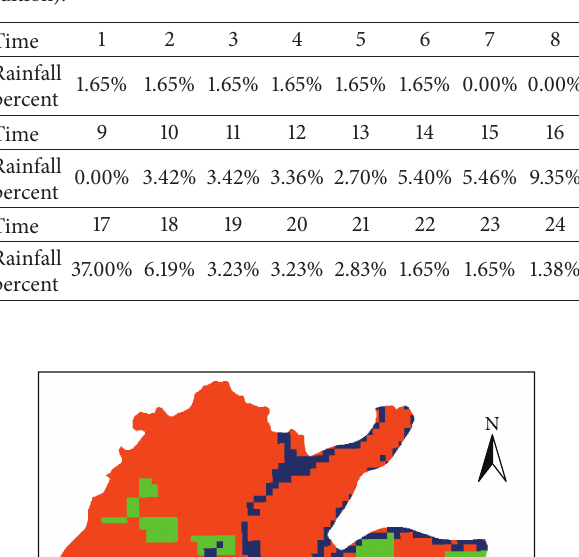
Table 4: The table of percent of hourly rainfall recommended in the Handbook of Heavy Rain and Flood in Jiangxi Province (2010 Edition).